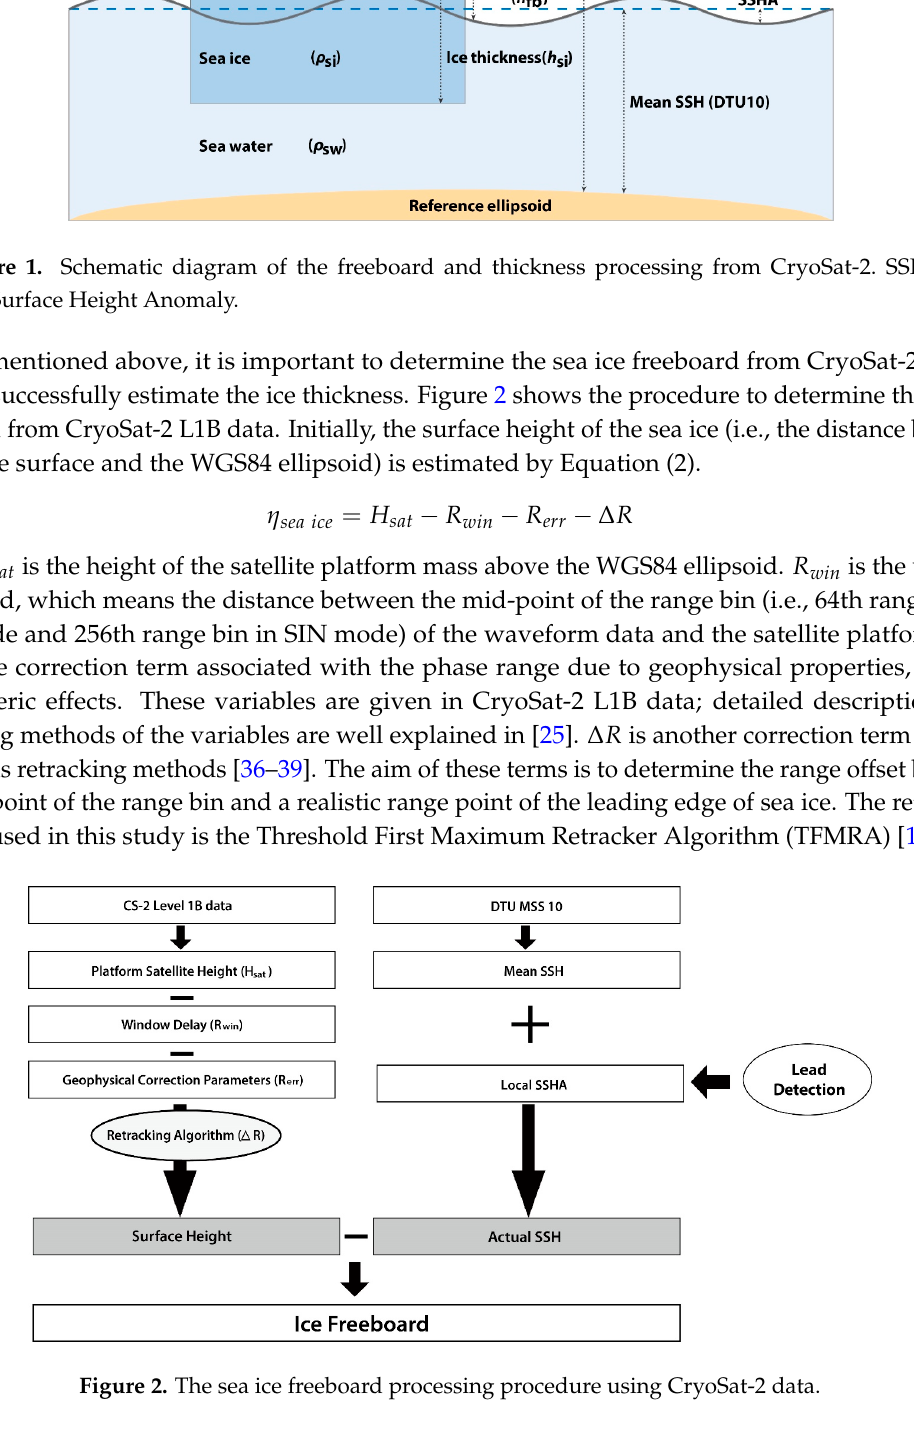
Figure 2. The sea ice freeboard processing procedure using CryoSat-2 data.